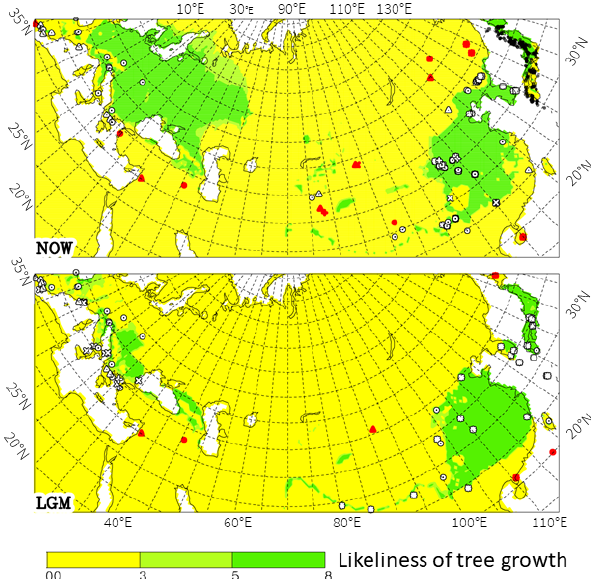
Figure 9. Same as Fig. 6 for the whole of Eurasia. Pollen data for Europe have been described by Arpe et al. (2011). Darker colours (green) are areas in which trees are able to grow according to model data. Lighter green indicates areas where not all criteria are com- pletely